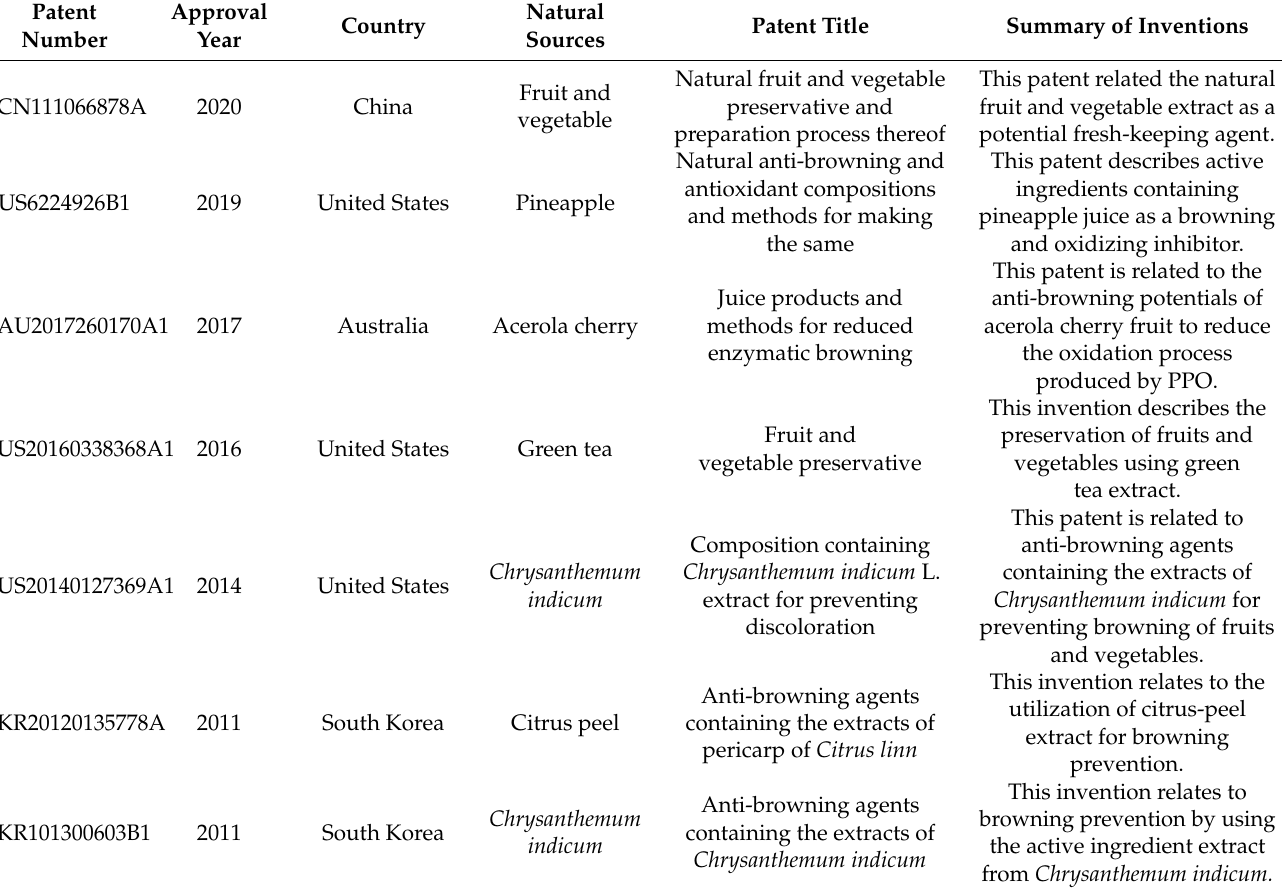
Table 2. Patents for recently explored studies on natural sources with anti-browning